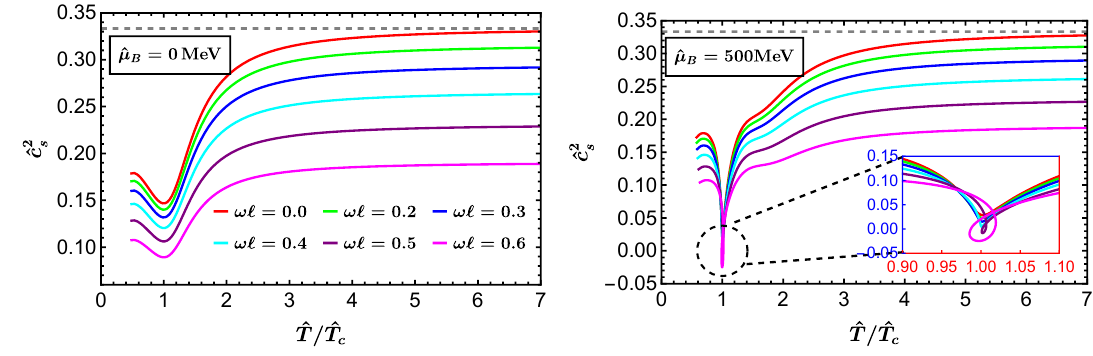
Figure 3 . The temperature dependence of ˆ c 2 at different angular velocity ω . At ˆ µ B = 0 MeV (left) s there is always crossover, while at ˆ µ B = 500 MeV (right) the phase transition changes from crossover to first-order by increasing ω .